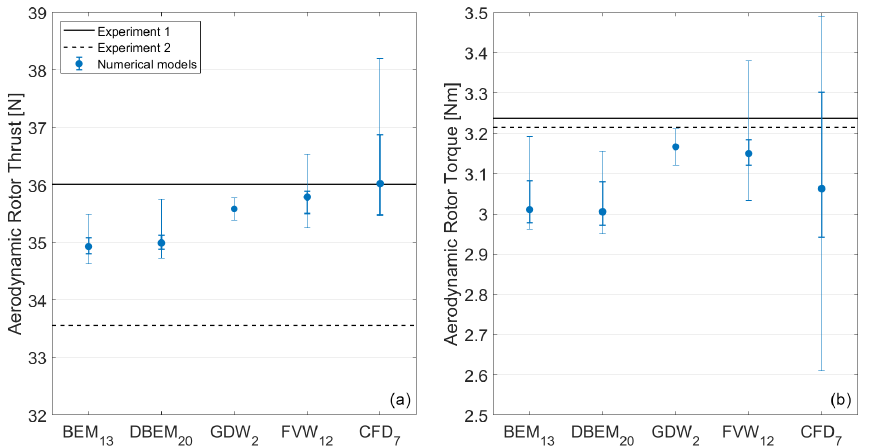
Figure 5. Aerodynamic rotor thrust (a) and torque (b) during the steady wind condition. Median and quartiles for the different simulation